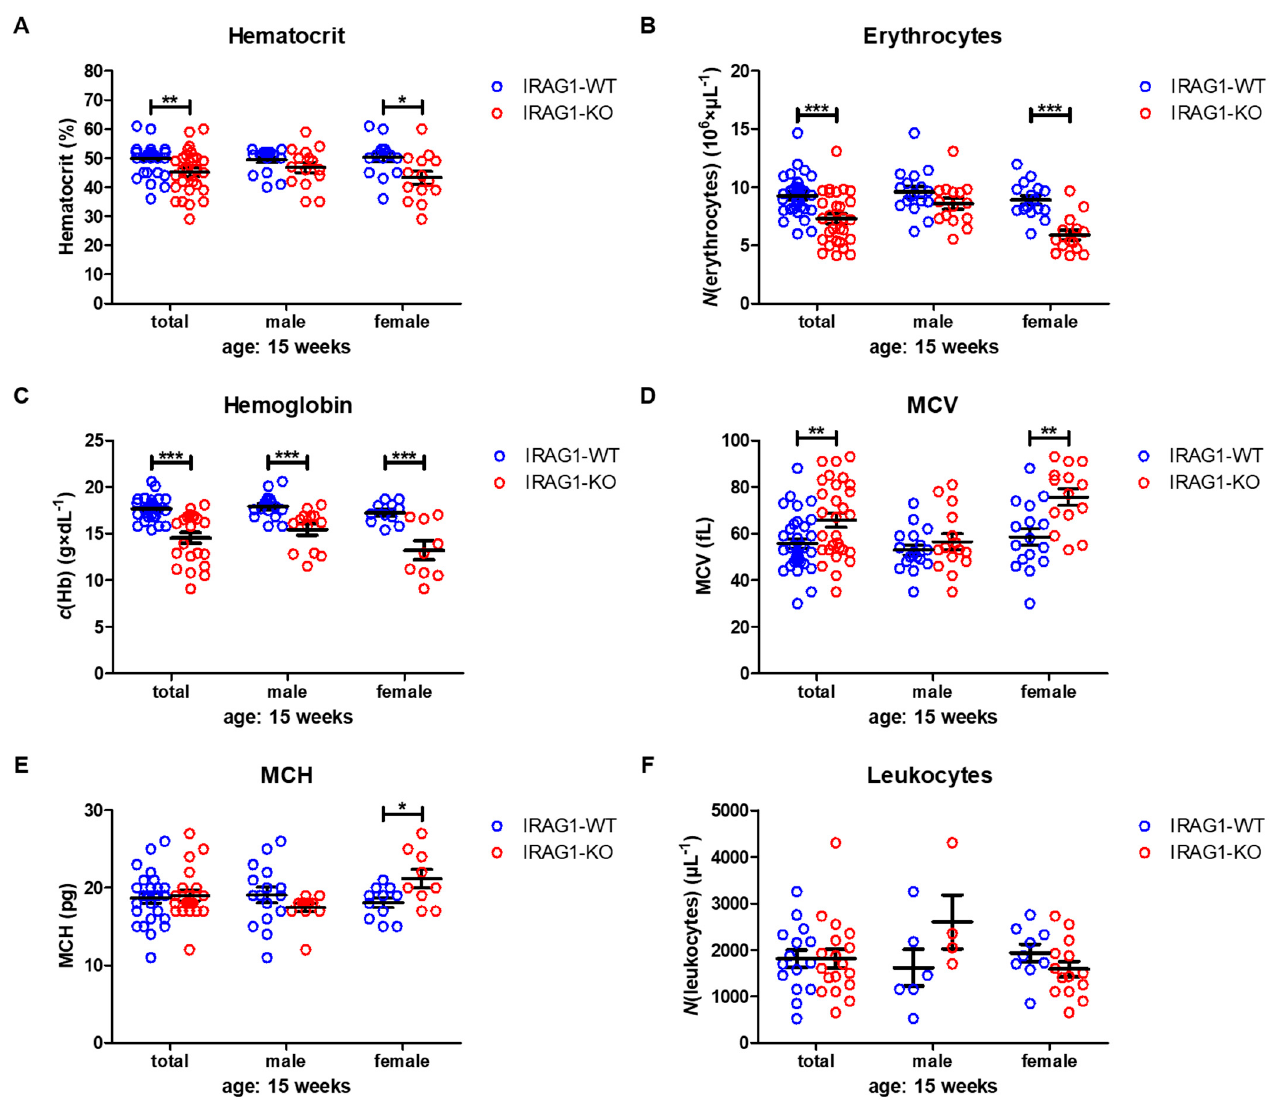
Figure 3. Hematological parameters of IRAG1-WT and IRAG1-KO mice. ( A ) Significant reduction of hematocrit in IRAG1-KO mice (total: n = 29; female: n = 14) in comparison to IRAG1-WT mice (total: n = 33 and female: n = 16) and no differences were detected in male IRAG1-WT ( n = 17) and IRAG1-KO mice ( n = 15). ( B ) Irag1 -deficiency reduced RBCs in IRAG1-KO (total: n = 29; female: n = 14) and had no effect in male IRAG1-KO mice ( n = 15) as compared with their WT littermates (total: n =33; male: n = 17; female: n = 16). ( C ) Significantly affected hemoglobin values of IRAG1-KO mice (total: n = 22; male: n = 13; female: n = 9) by the Irag1 -deficiency compared to WT littermates (total: n = 27; male: n = 16; female: n = 11). ( D ) MCV was significantly increased in IRAG1-KO mice (female: n = 14; total: n = 29) compared to IRAG1-WT (female: n = 16; total: n = 33), and no difference was found between male IRAG1-WT ( n = 17) and IRAG1-KO mice ( n = 15). ( E ) MCH was not affected by Irag1 -deficiency in male mice (IRAG1-WT: n = 16; IRAG1-KO: n = 13) and in total (IRAG1-WT: n = 27; IRAG1-KO: n = 22). Female IRAG1-KO mice ( n = 9) developed a significantly higher MCH compared to their WT littermates ( n = 11). ( F ) WBCs were not different between IRAG1-WT mice (total: n = 15; male: n = 6; female: n = 9) and IRAG1-KO mice (total: n = 18; male: n = 4; female: n = 14). Circles indicate the individual value of each mouse and mean ± SEM is shown by bars. Significant differences are shown by (*) ( p < 0.05), (**) ( p < 0.01) and (***) ( p < 0.001).